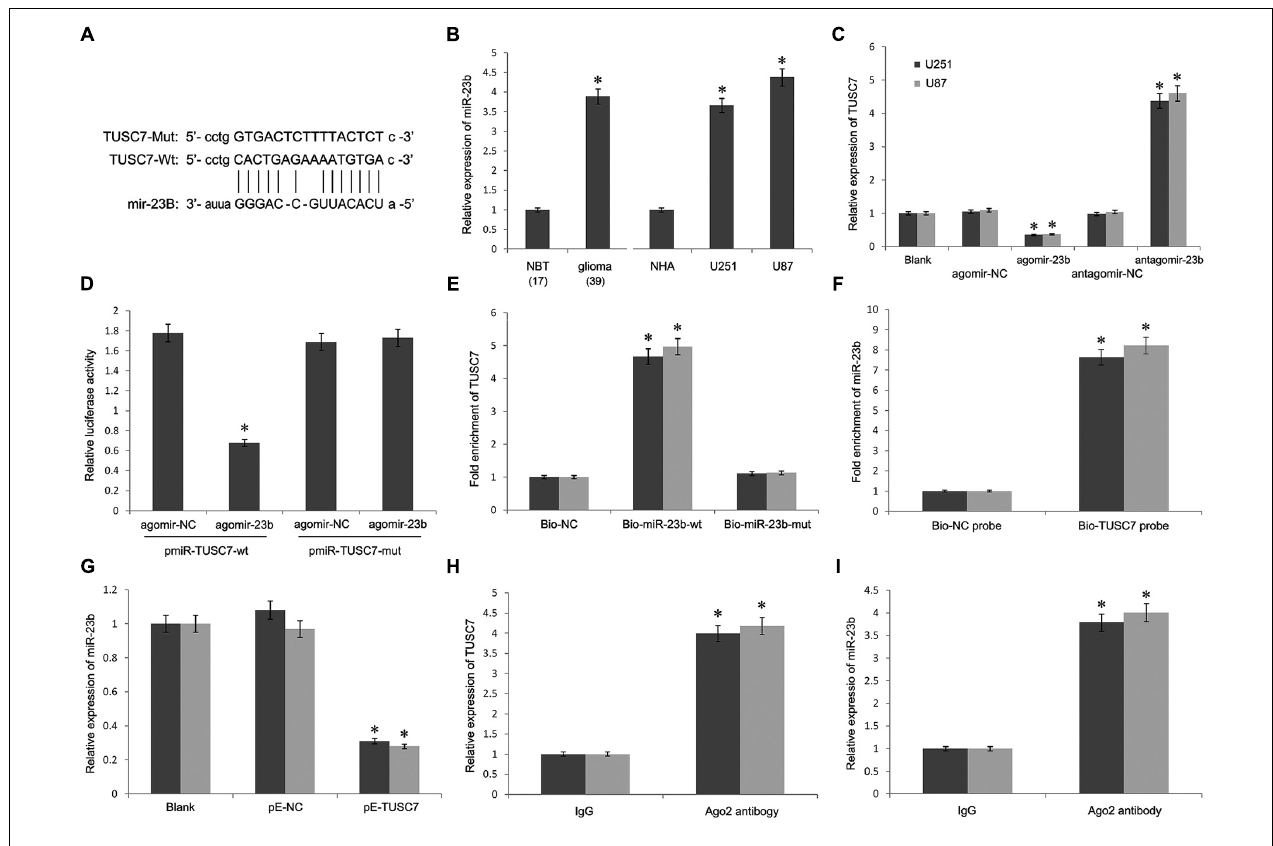
FIGURE 4 | (A) Putative binding sites of miR-23b within TUSC7 mRNA, and the sequences of wild-type and mutant-type vectors. (B) MiR-23b was highly expressed in human glioma tissues and cell lines. (C) Compared with control groups, agomir-23b increased the expression of miR-23b in U251 and U87 cells, antagomir-23b inhibited miR-23b expression. (D) The relative luciferase activities were inhibited in the HEK-293 cells co-transfected with wild-type vector and p agomir-23b, and not with the mutant-type vector. Firefly luciferase activity was normalized to Renilla luciferase. (E) Detection of TUSC7 mRNA using qRT-PCR in the sample pulled down by biotinylated miR-23b. (F) Detection of miR-23b mRNA using qRT-PCR in the sample pulled down by biotinylated TUSC7. (G) MiR-23b expression was down-regulated significantly by TUSC7 over-expression in U251 and U87 cell lines. (H,I) Association of TUSC7 and miR-23b with Ago2 in U251 and U87 cells. Cellular lysates from U251 and U87 cells were used for RIP with antibody against Ago2. TUSC7 and miR-23b expression levels were detected using qRT-PCR. ∗ P <